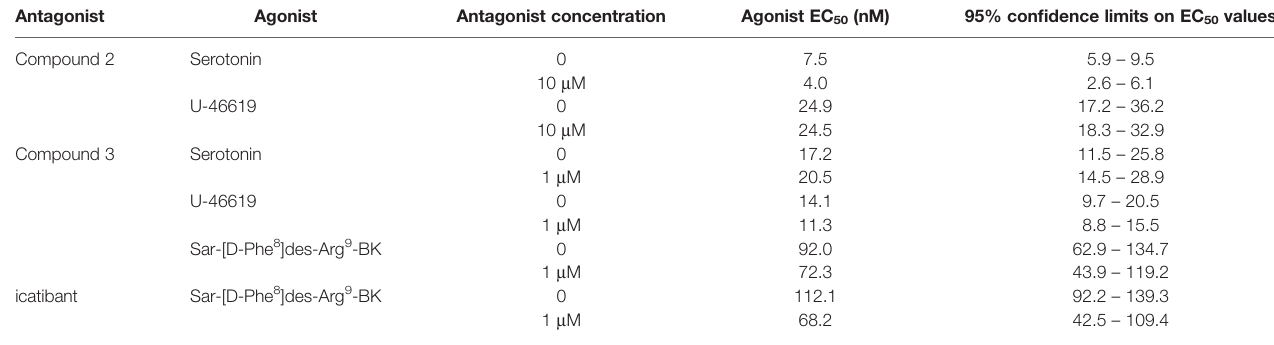
TABLE 5 | Agonist EC 50 values in speci fi city experiments ( Figure 5 ). Antagonist Agonist Antagonist concentration Compound